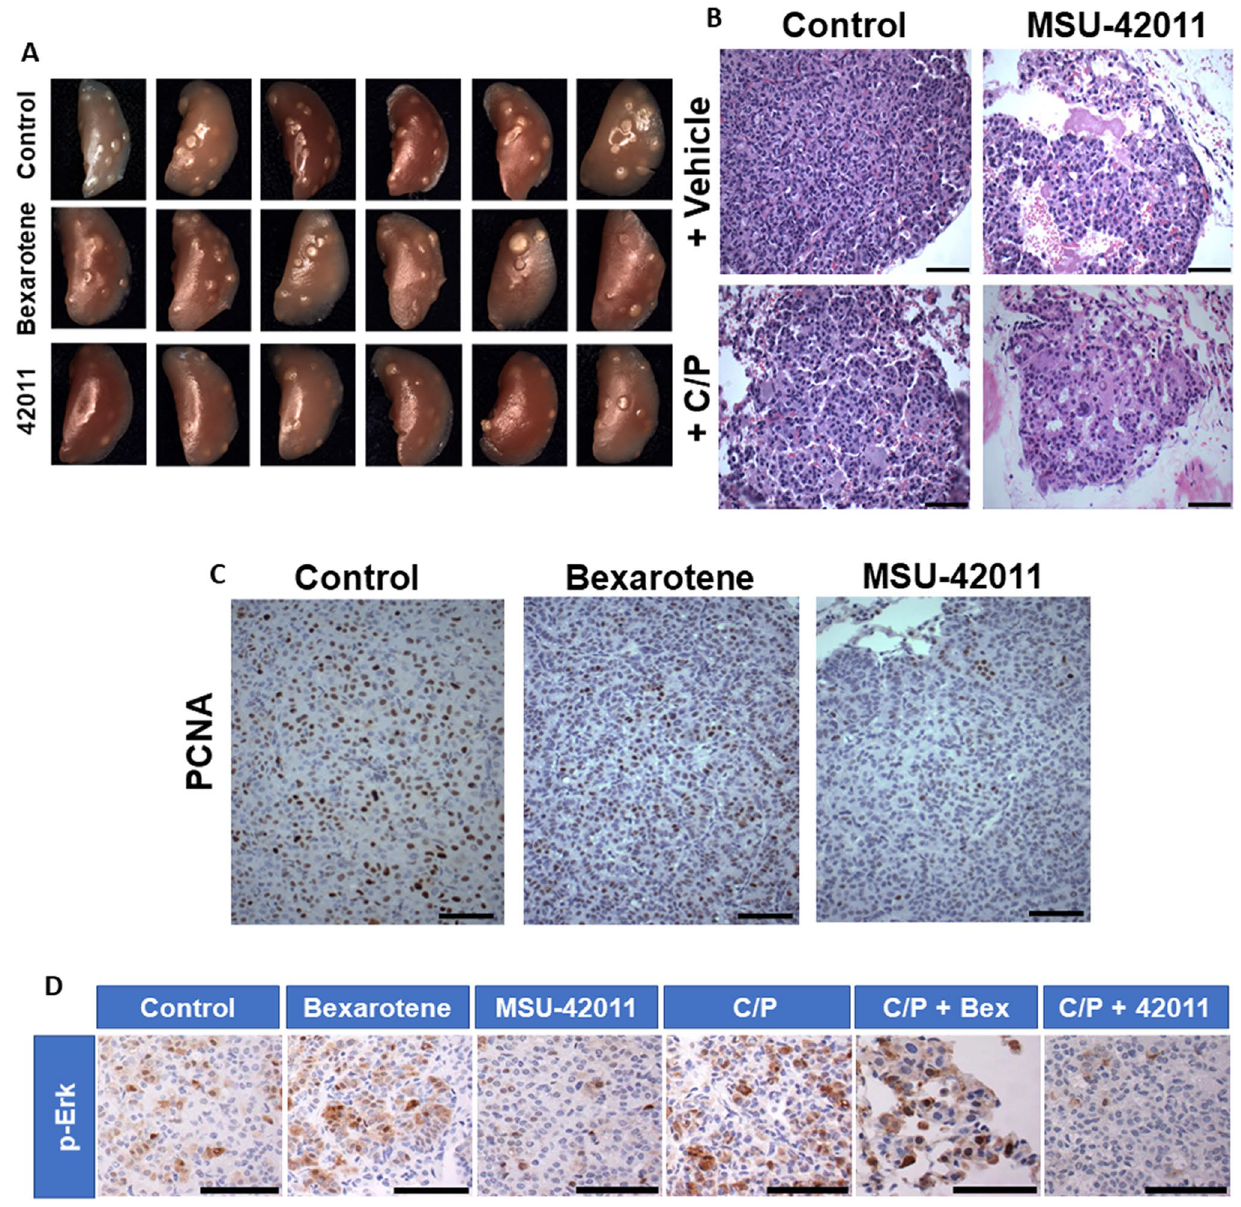
Figure 3. MSU-42011 alone decreases tumor burden and induces beneficial changes in tumor structure. Vinyl carbamate was used to initiate lung carcinogenesis in A/J mice. Starting 8 weeks after initiation, mice were fed experimental diets containing rexinoids (100 mg/kg diet), alone or in combination with carboplatin and paclitaxel (C/P) as described in Table 1. After 12 weeks of treatment, lungs were harvested and representative pictures ( A , 8X magnification) of the left lungs from each group are shown. Changes in the histological architecture of the tumor are shown by H & E staining of tumor sections ( B ; scale bar = 60 microns) and proliferation of cells or Ras signaling within the tumor was analyzed by immunohistochemistry for proliferating cell nuclear antigen ( C ) or p-ERK expression ( D ), respectively . Scale bar = 60